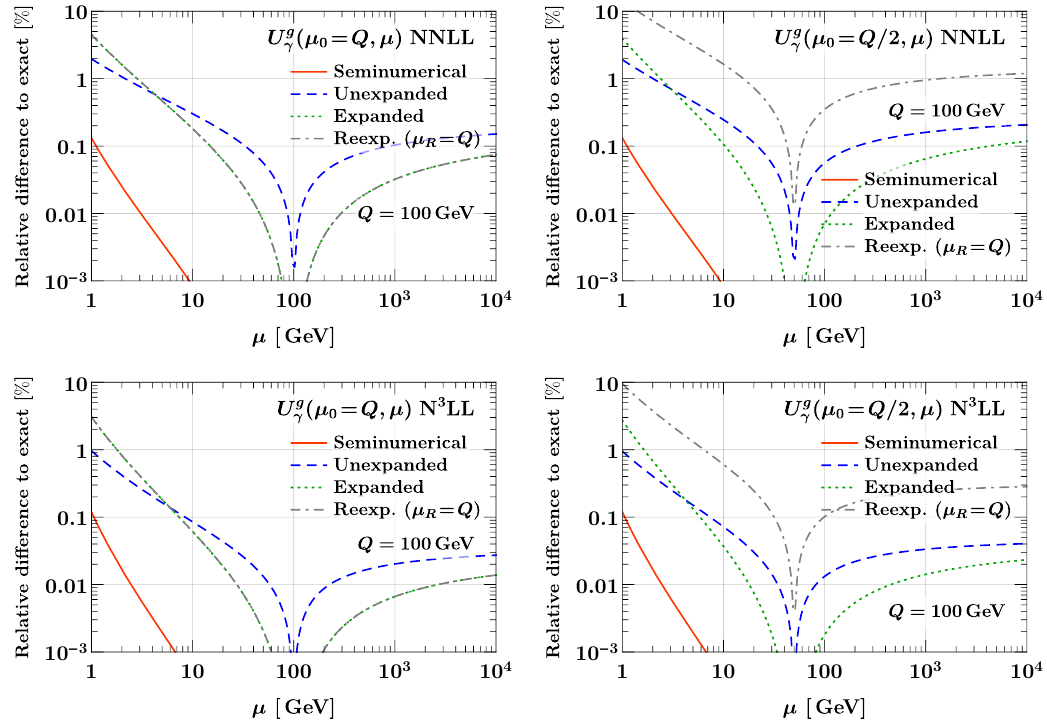
Figure 9 . Same as (cid:12)gure 7, but for the gluon noncusp evolution kernels.